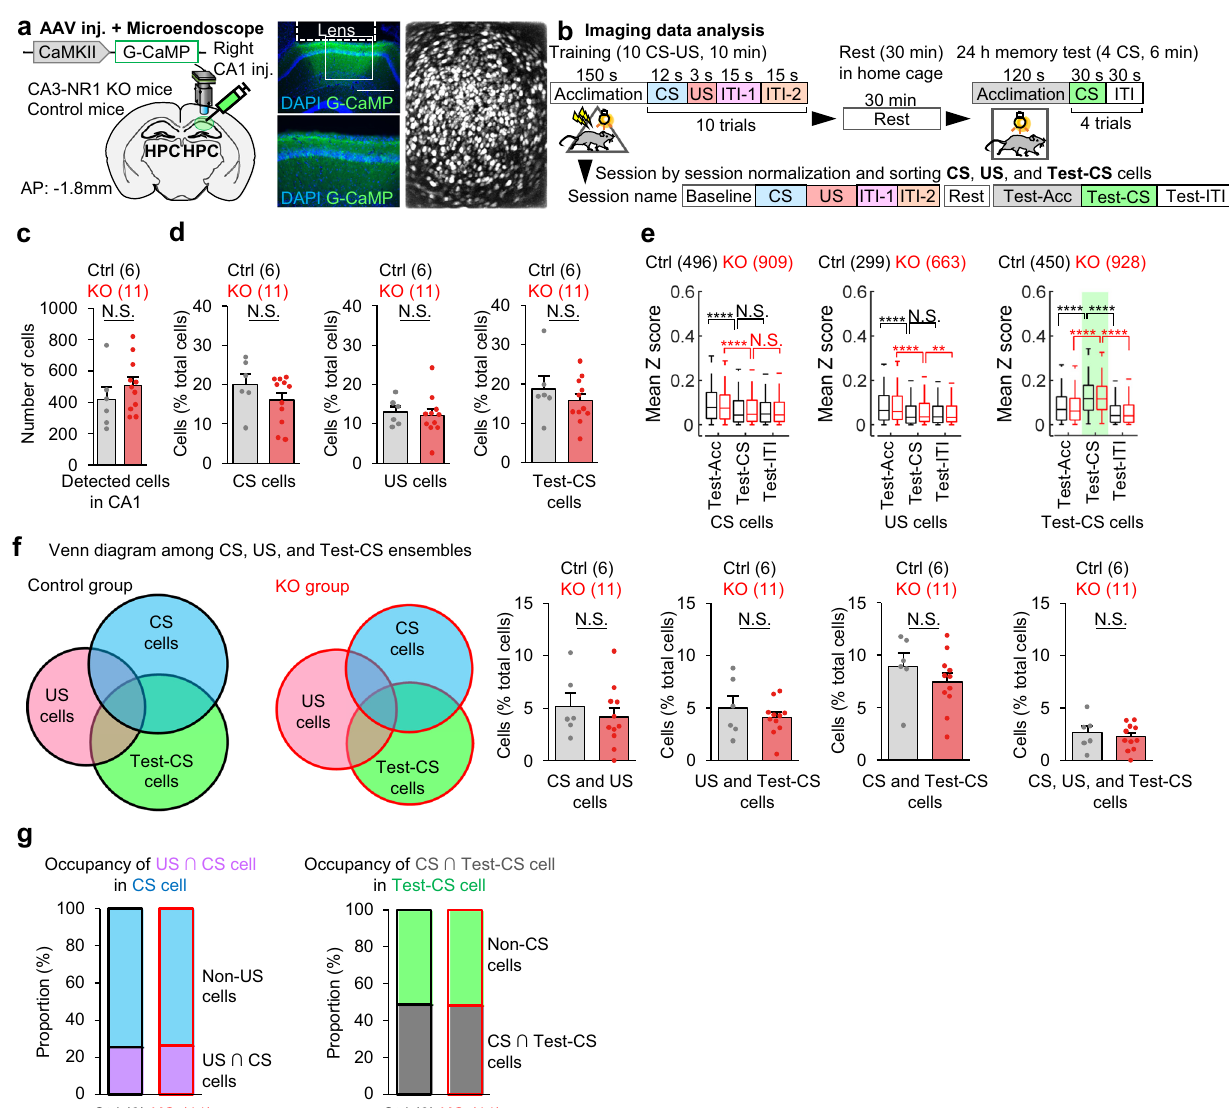
Fig. 2 | CA3-NR1 KO mice exhibited normal CA1 ensemble structure. a Left, experimental design. Right, coronal section of the hippocampus with G-CaMP expression, GRIN lens implantation, and stacked dF/F image acquired using a microendoscope over entire recording sessions of hippocampal imaging. Similar expression pattern was con fi rmed at least 5 times independently. Scale bar, 500 μ m. b Imaging data analysis scheme. In each cell, Ca2 + data is classi fi ed into nine sessions, and the calculated mean z-score is considered to represent responsiveness and sorted into CS-, US-, and Test-CS-responsive subpopulations. c ColumnscomparingnumberofdetectedcellsduringCA1imagingincontroland CA3-NR1KOmice. d ColumnscomparingpercentofensemblesizeinCS-,US-,and Test-CS-responsive subpopulations between control and KO mice. e Box plots comparing mean z-scores of long-term memory test sessions between genotypes in CS-, US-, and Test-CS-responsive subpopulations (two-tailed paired Wilcoxon signed-rank test: Ctrl CS cells Test-ACC to Test-CS, P =1.2E-06; KO CS cells